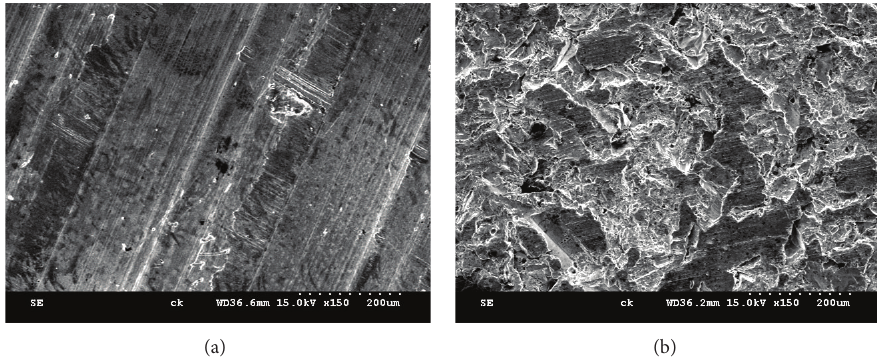
Figure 8: SEM images of test specimens (a) MM1, (b) AJM1, with load 2.0 MP and at friction distance 1000